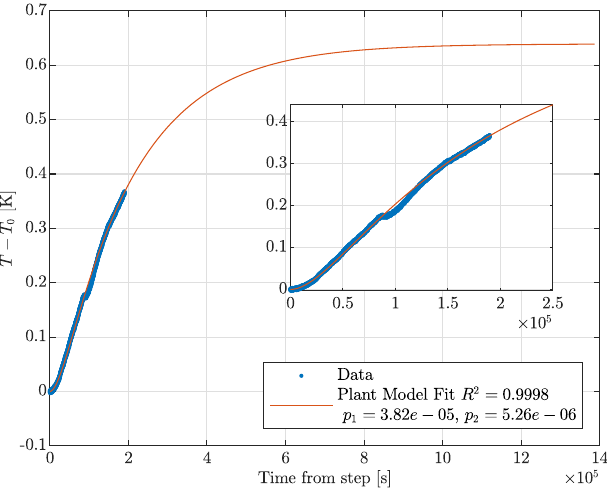
Figure 4. Two-pole plant model estimation for the north mirror step response. A system response with poles at 38.2 and 5.26 µ Hz fit to the data yielded R 2 = 0.9998. The slight dip in the data is due to the ITF unlocking. The west arm exhibits similar behavior, albeit a slightly less goodness of